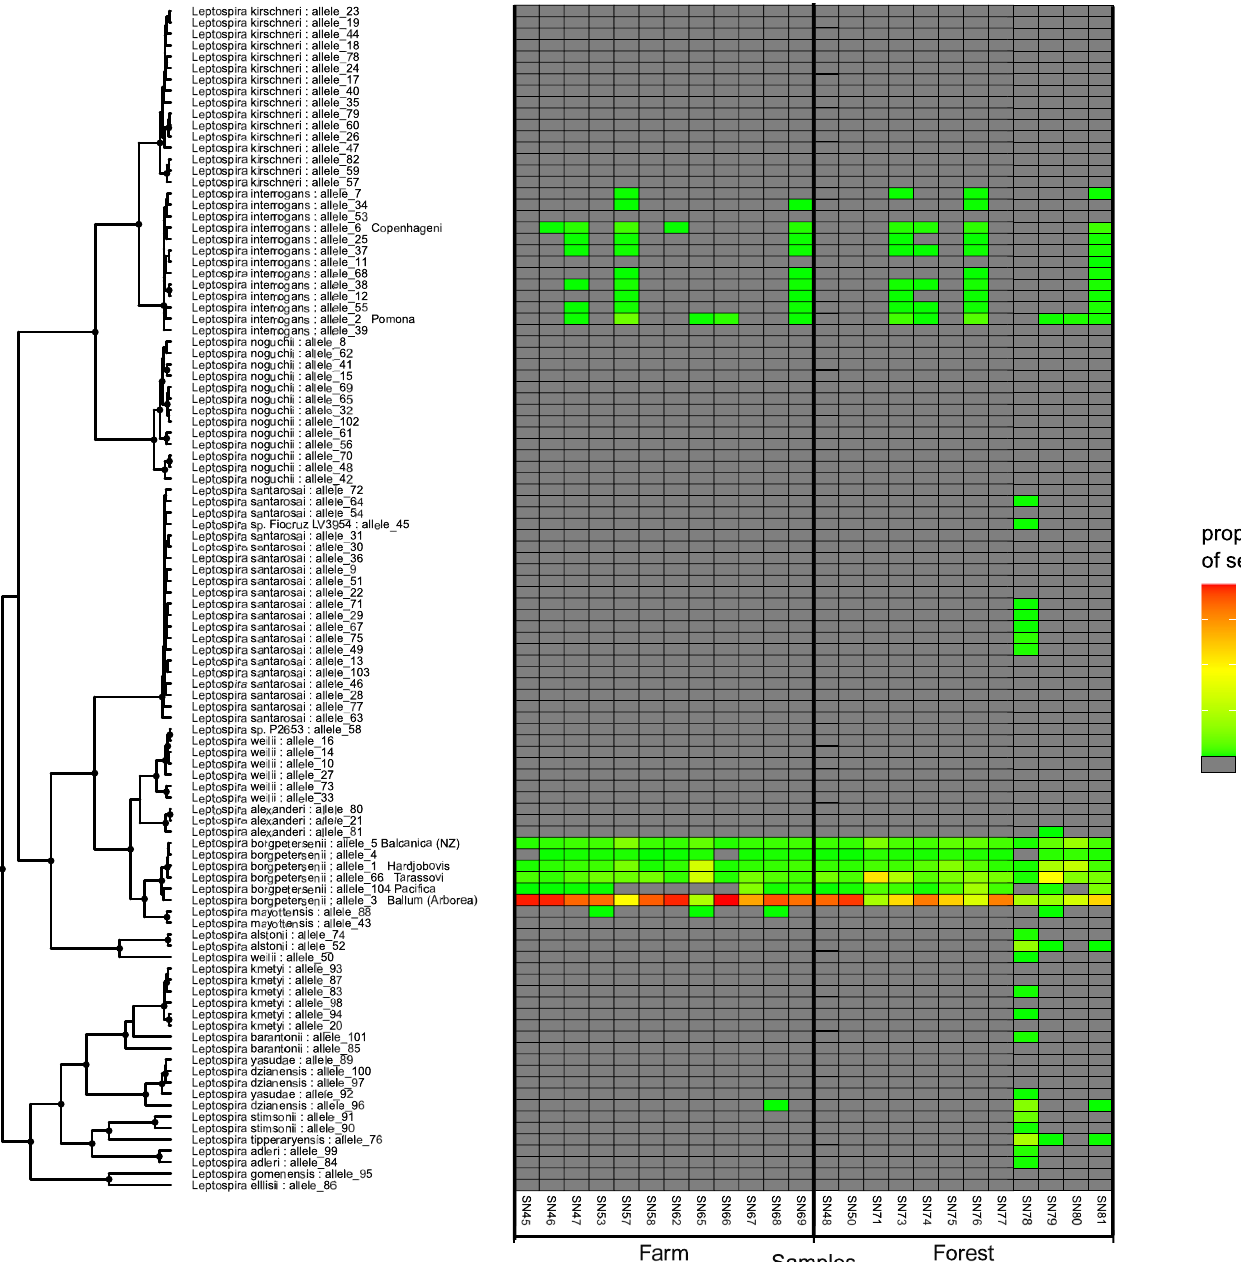
Fig 5. Leptospira variant identification using metabarcoded primers amplifying the glmU locus from enriched environmental cultures from a dairy farm and a neighbouring forest using Oxford Nanopore sequencing. Results are displayed relative to the phylogenetic position for each allele in the glmU -derived phylogenetic